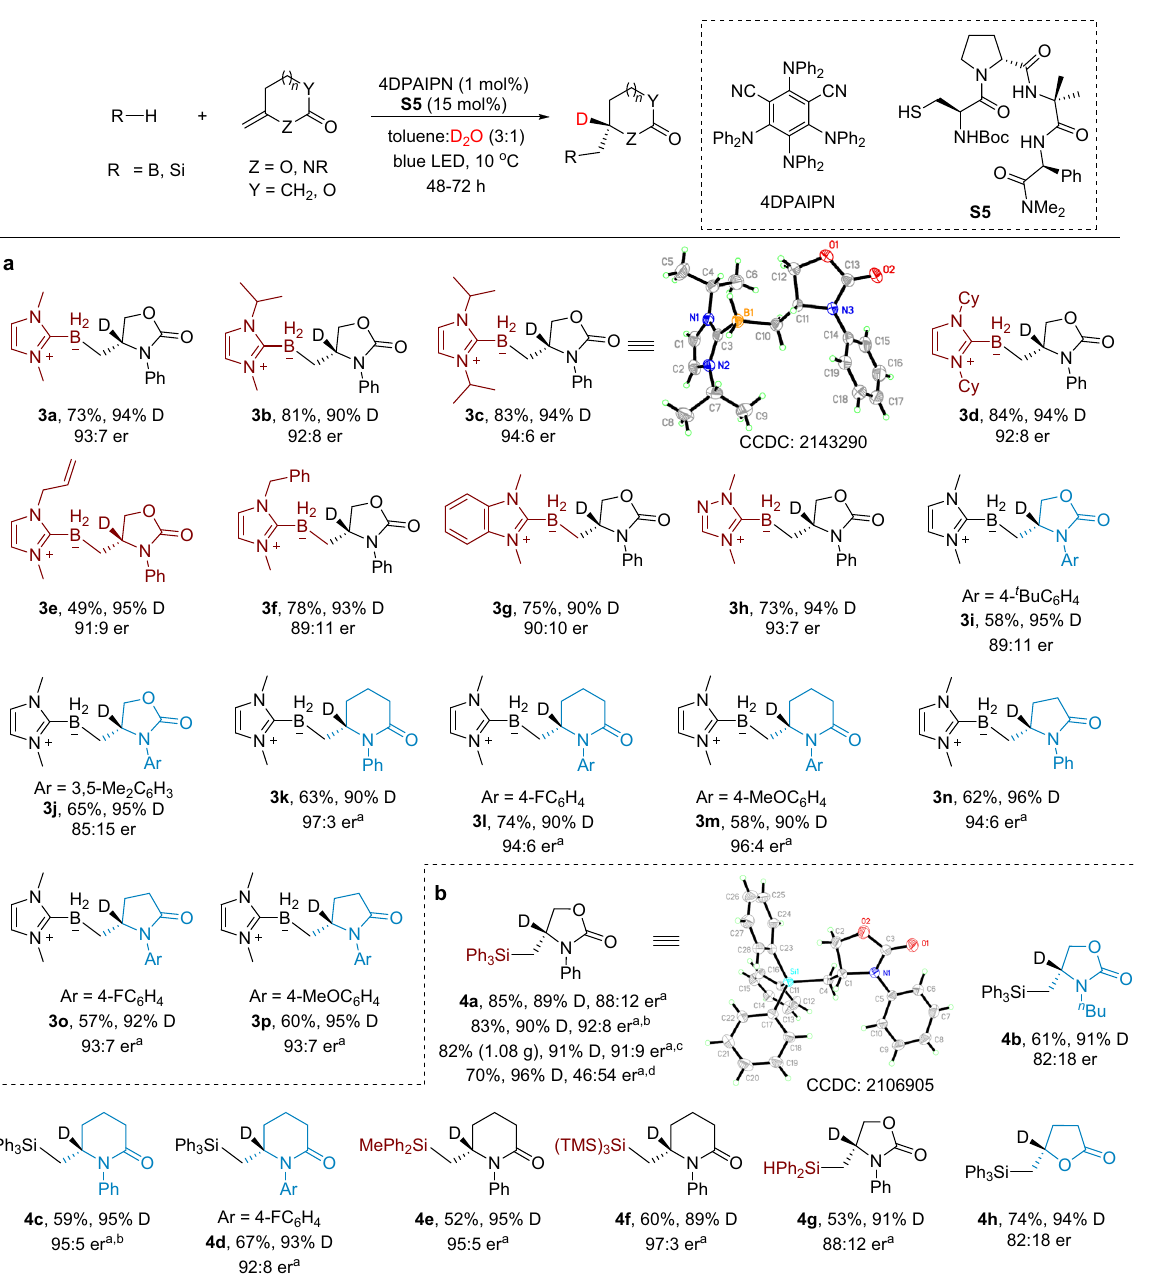
Supplementary Note 2.3 for experimental details. a Reaction was conducted at rt. b S7 was used instead of S5 . c Gram-scale reaction with 4DPAIPN (0.5mol%) and S7 (10mol%). d S1 was used instead of S5